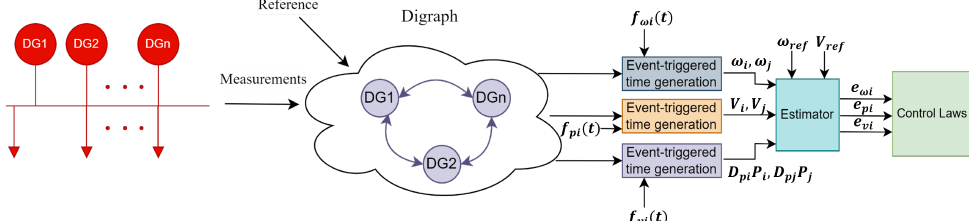
Figure 11. Implemented secondary event-triggered controller based on an multiple event- triggered